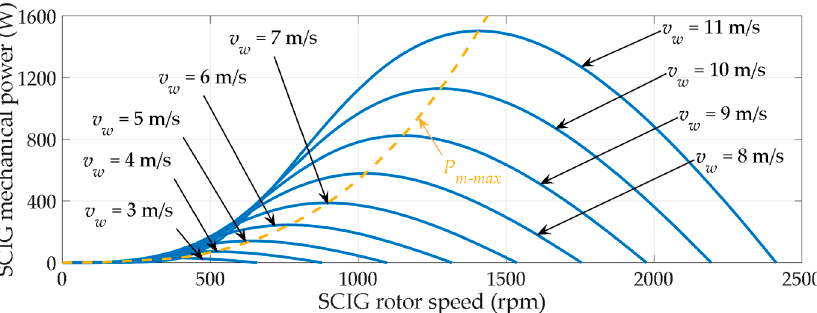
Figure 3. Mechanical power vs. rotor speed characteristics of the utilized WT-driven SCIG.